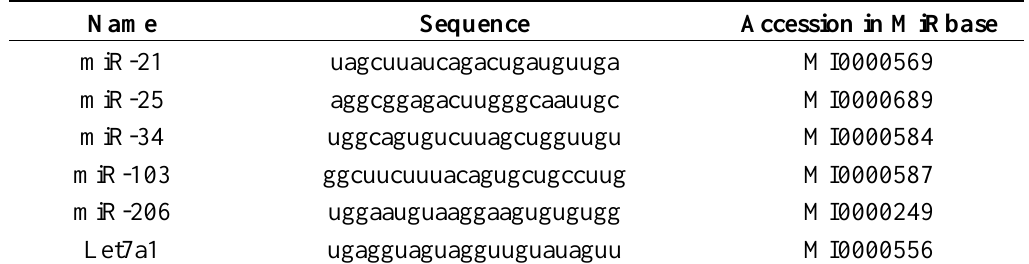
Table 1 . Sequences from the miRNAs used in this study.